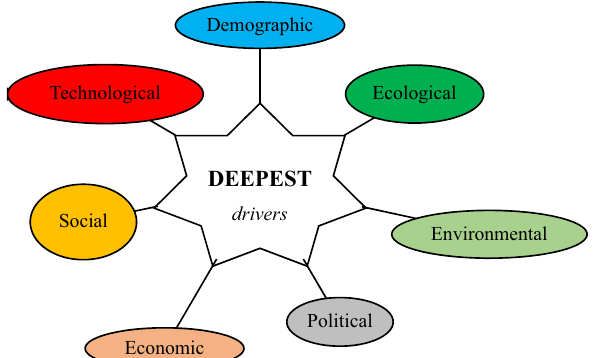
Figure 1. DEEPEST holistic framework